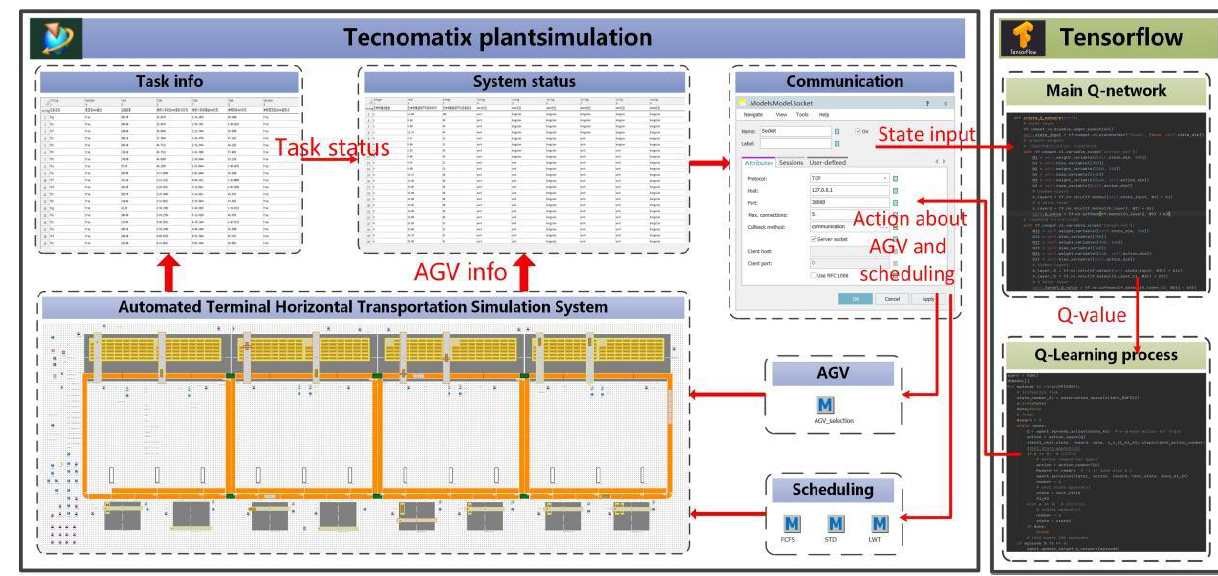
Figure 6. Dynamic scheduling of automated terminal AGVs based on DQN.